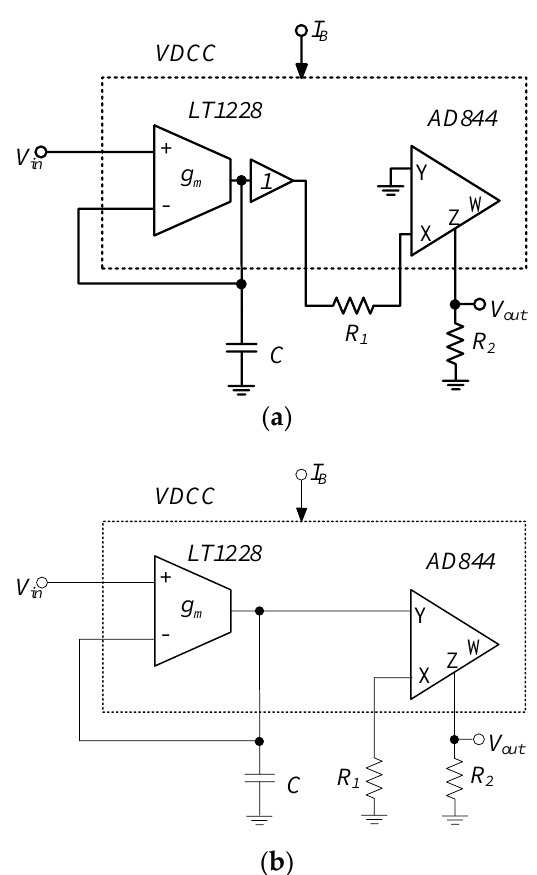
Figure 9. Commercially available ICs-based lossy integrator ( a ) inverting configuration ( b ) non- inverting configuration.